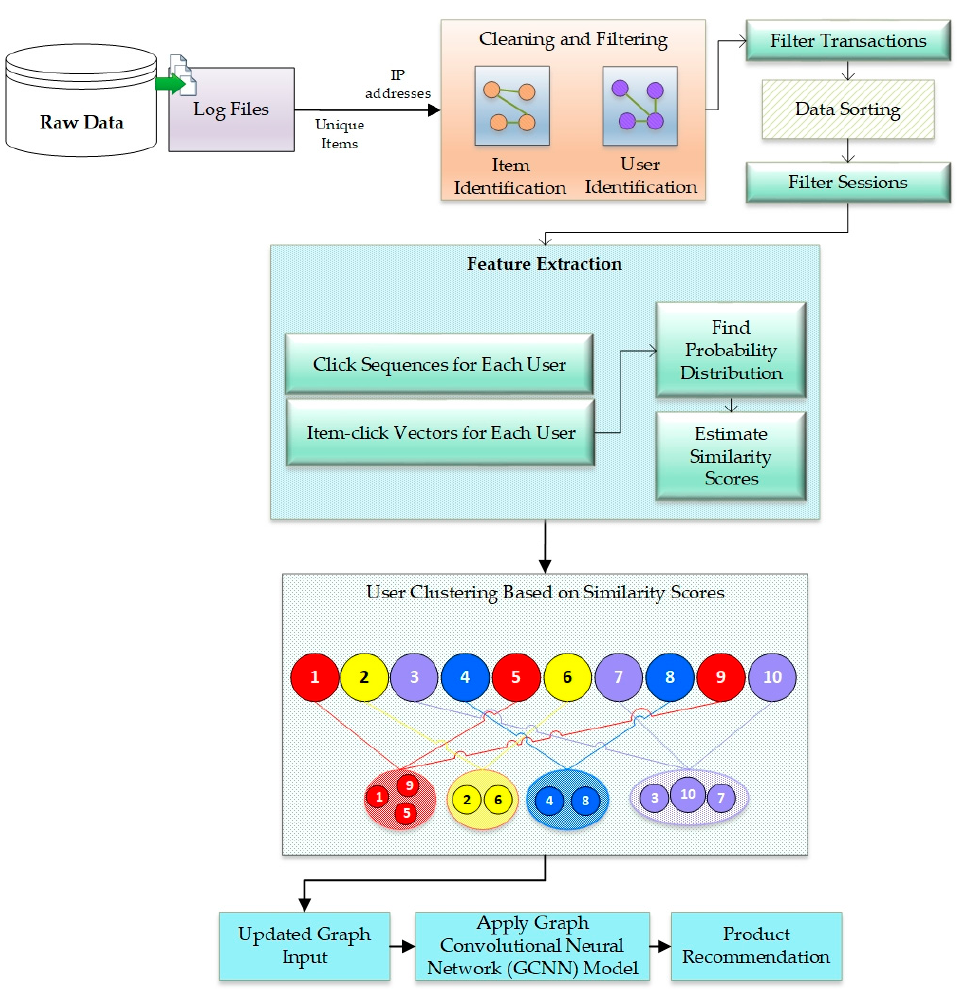
Figure 2. The conceptual flow of the proposed framework.